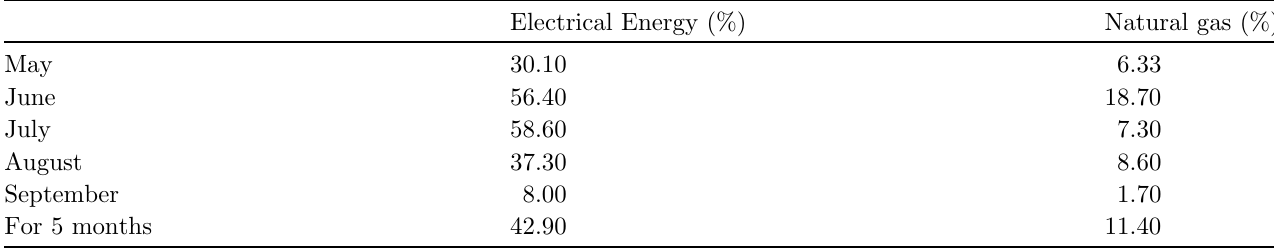
Table 4. Percentage of energy saving in scenario 2 in comparison with scenario 1 for electric and natural gas consumption during investigated fi ve month.